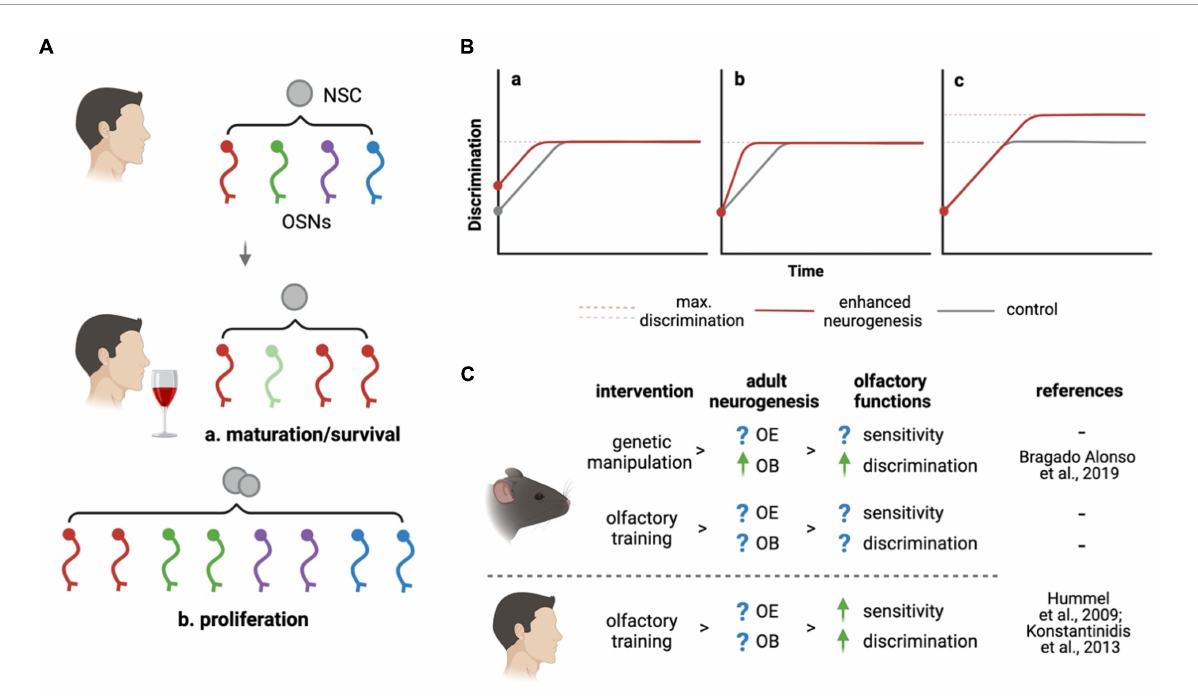
FIGURE1 How can adult neurogenesis promote olfaction? (A) At the level of the peripheral nervous system, adult neurogenesis may respond to olfactory stimuli changing the abundance of specific OSNs (indicated by colors) by (a) changing the maturation or survival of immature OSNs or (b) increasing neurogenesis itself. (B) Effects of enhanced (red lines) relative to basal (gray) brain neurogenesis on olfactory discrimination are modeled based on (a) improved innate ability, (b) learning, or (c) maximal performance. Combinations thereof were not depicted. (C) Olfactory experience may act both in humans and rodents on olfactory neurogenic niches supporting functions such as sensitivity or discrimination. Converse to Bragado Alonso et al. (2019) decrease in neurogenesis and discrimination was reported by Li et al. (2018). Figure created with